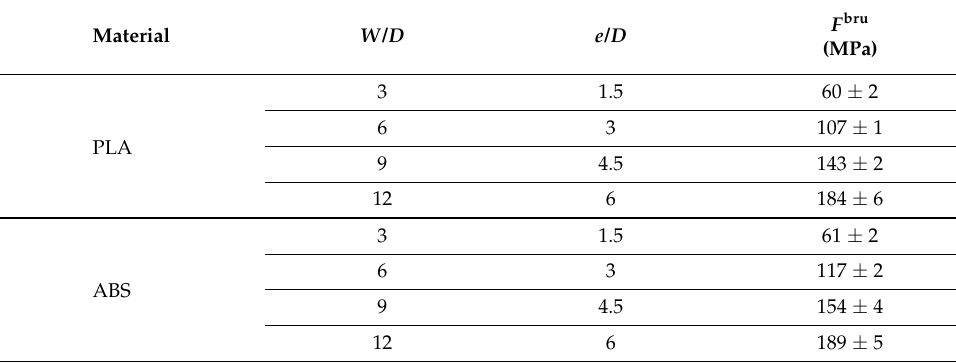
Table 3. The ultimate bearing strength of tested